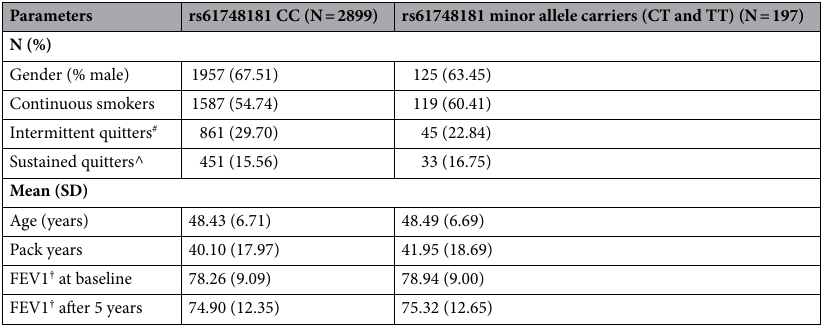
Table 1. The demographic profile of the LHS population*. *Caucasian only. ^Sustained quitters are defined as abstinence from all smoked tobacco products at all 5 years of the LHS annual follow up visits (Y1-Y5), confirmed by salivary cotinine and expired carbon monoxide data. # Intermittent quitters consist of self-report smoking history in any annual visits (Y1-Y5); and participants who failed any validation tests. Participants who did not attend a given annual visit were counted as smokers in that visit, and an intermittent quitter. † % of predicted